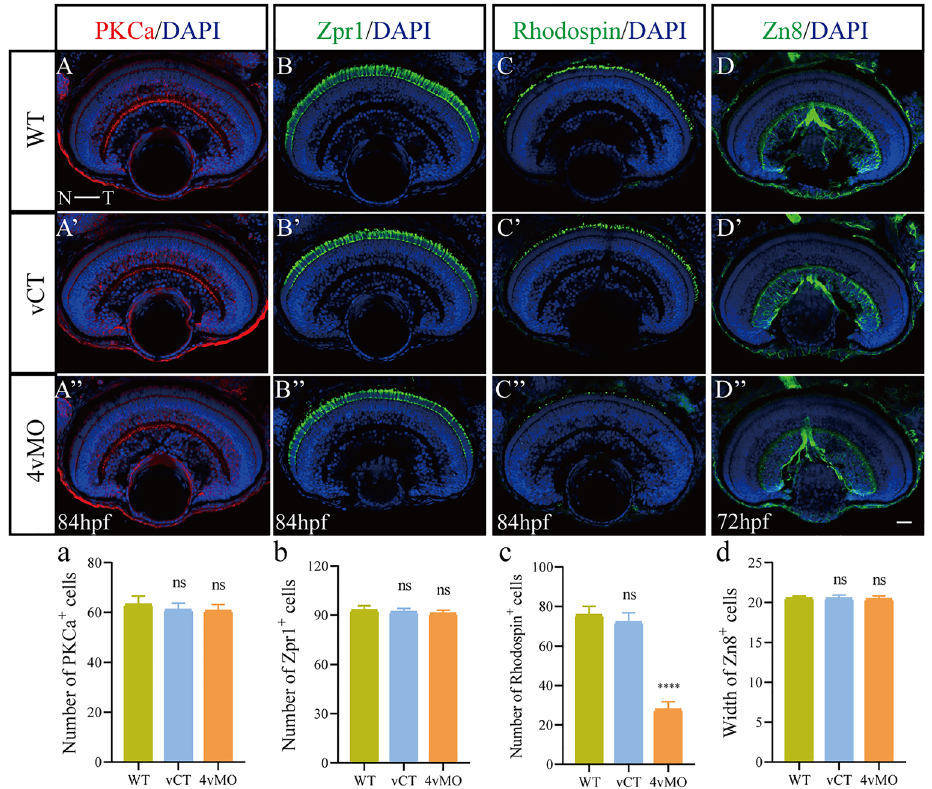
Figure 3. Effects of lhx4 knockdown via vivo - MO in the eyes on the other retinal neuronal differentiation. All figures are horizontal sections along the temporal-nasal axis (T-N). ( A – D” ) Immunofluorescence staining with other retinal neural markers, PKCα (at 84 hpf), Zpr1(at 84 hpf), Rhodopsin (at 84 hpf), and Zn8 (at 72 hpf) in WT, vCT, and 4vMO retinas. Blue, DAPI staining of the nuclei. Scale bar = 20 μm. ( a – d ) Statistical analysis of PKCα + , Zpr1 + , Rhodopsin + , and Zn8 + cells in WT, vCT, and 4vMO retinas. ns, P > 0.05; ****, P < 0.0001; vCT vs. WT; 4vMO vs. vCT. Results are presented as the mean ± SEM (n ≥